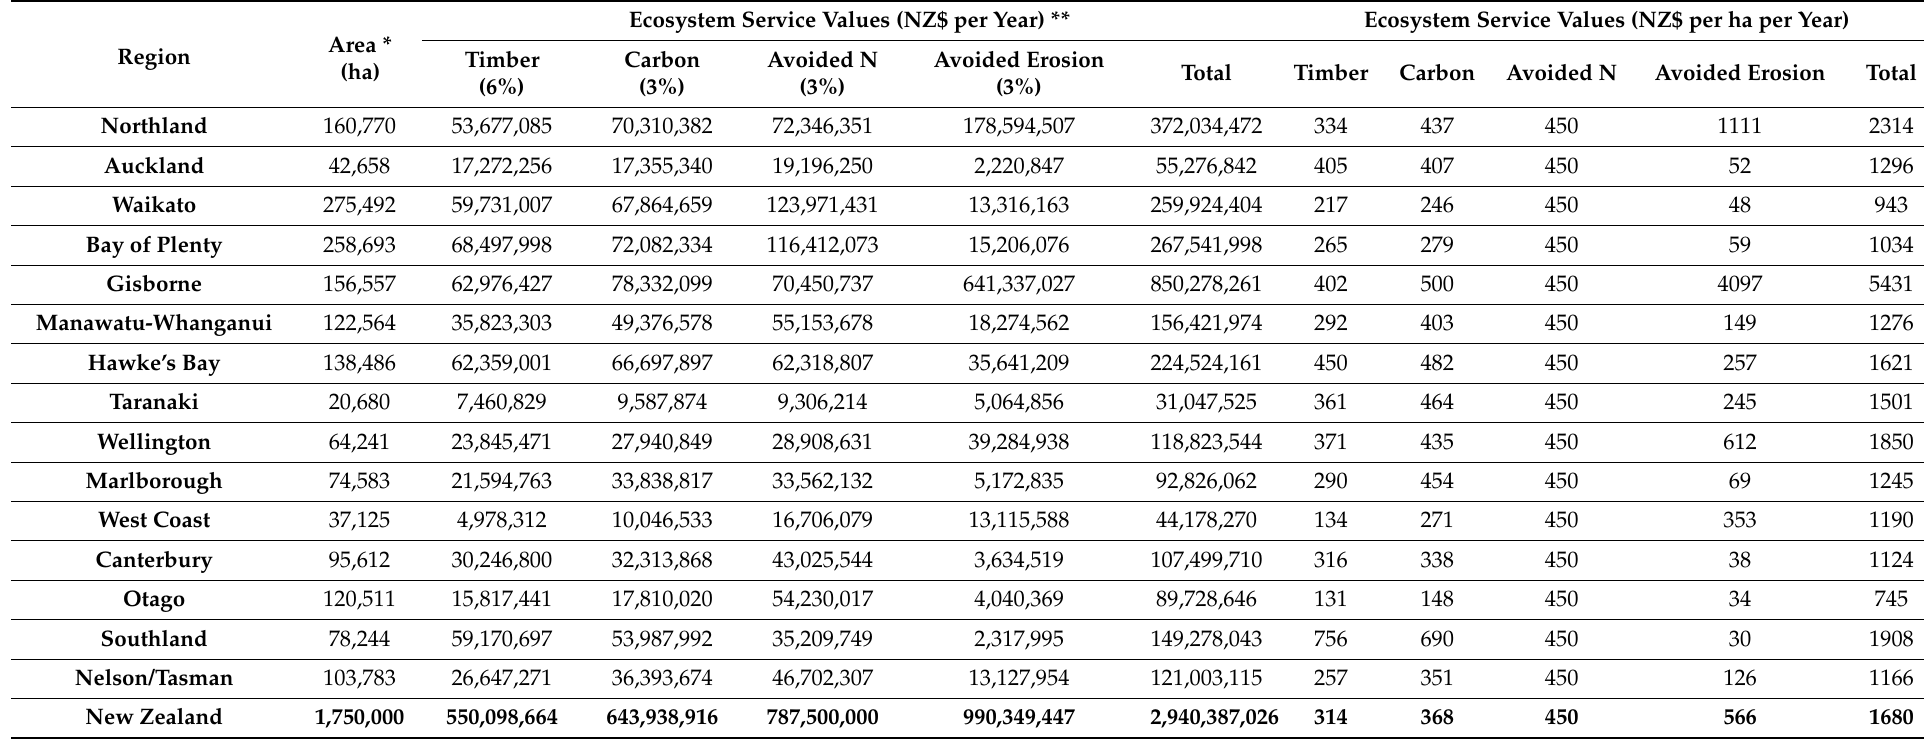
Table 1. Calculated values of the four forest ecosystem services by